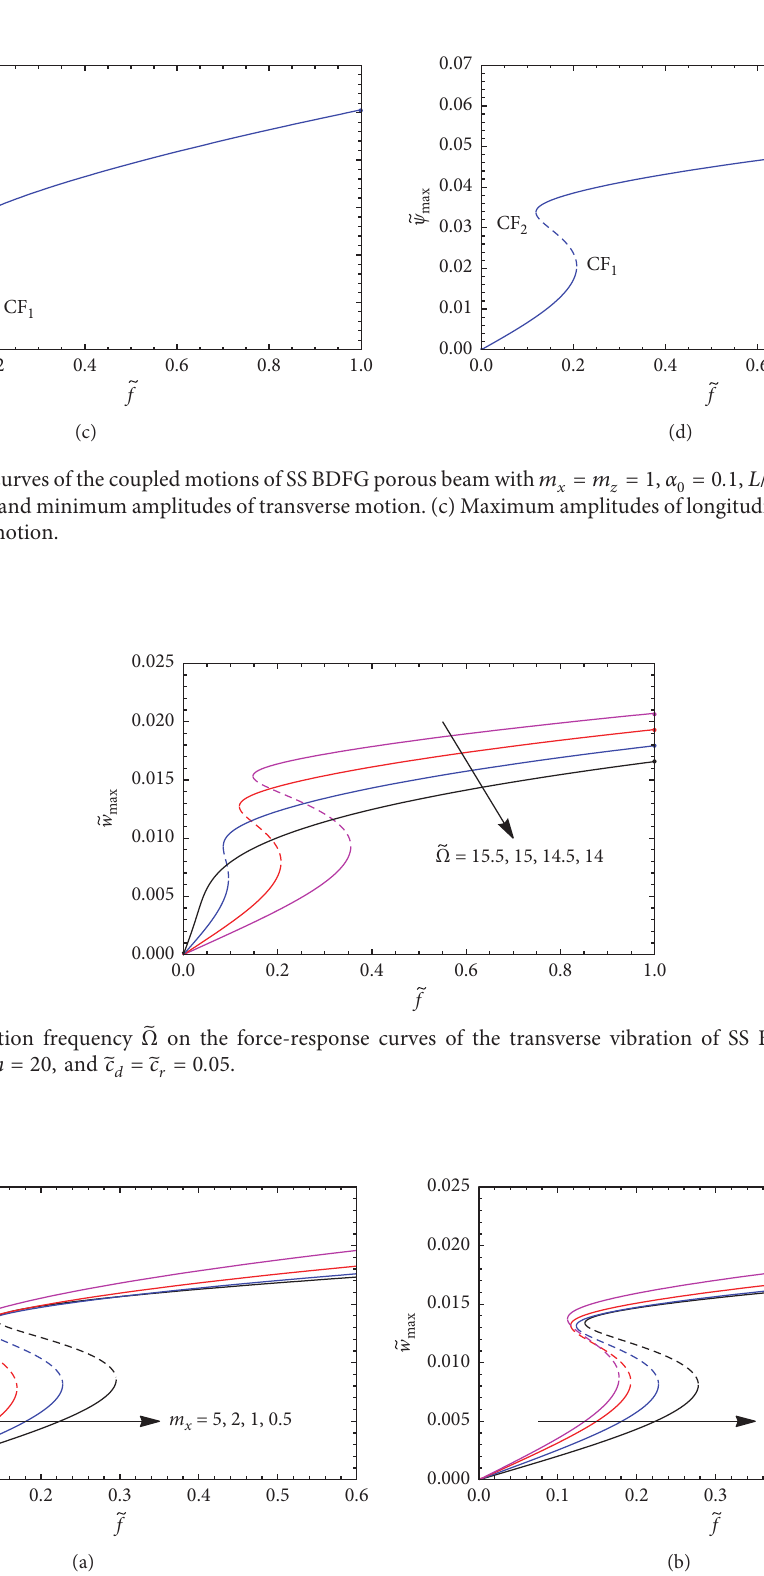
m x and z on the force-response curves of transverse vibration of BDFG porous beam � 1 and varying m z